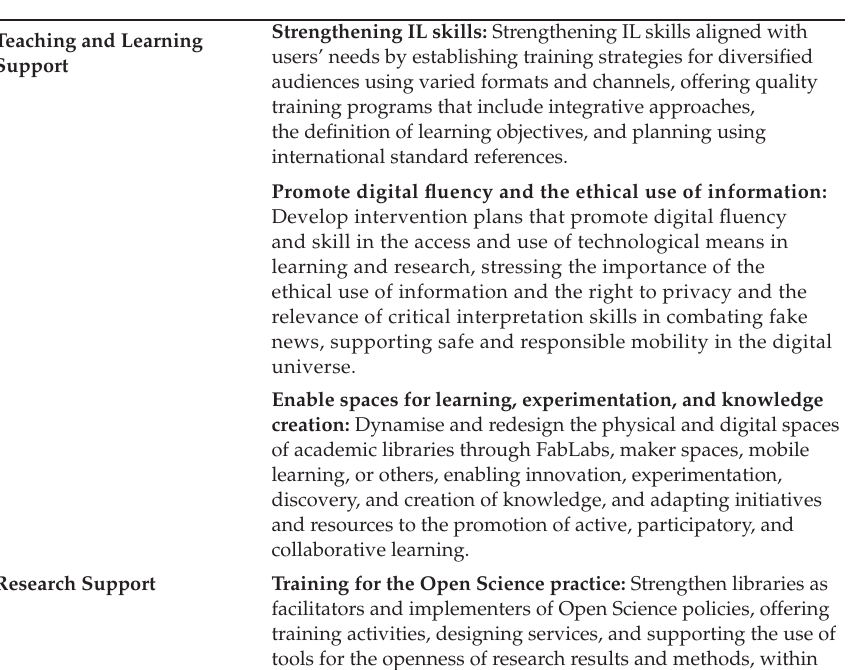
Table 2: The Portuguese Recommendations for Academic Libraries